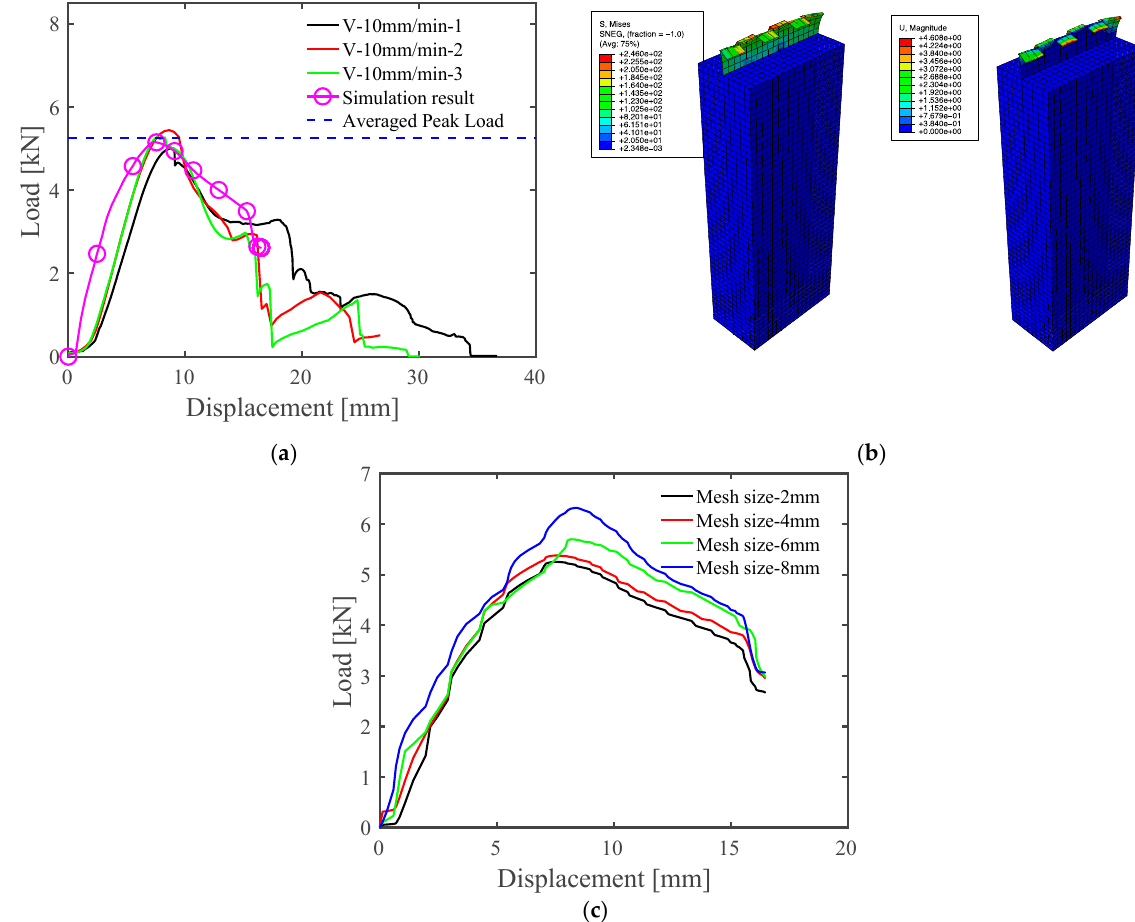
Figure 6. Results of the lab-scale SSMR tests: ( a ) displacement vs. load of the lab-scale test and FE result; ( b ) numerically predicted von Mises stress and displacement; ( c ) numerically predicted displacement vs. load of the FE results with different mesh sizes.